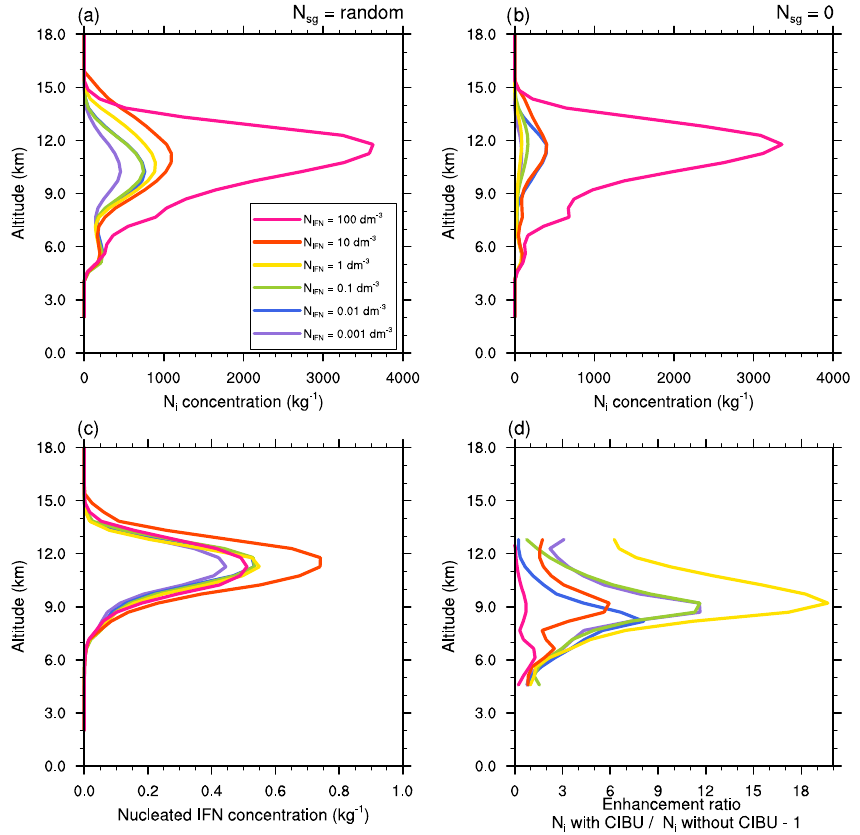
Figure 14. Mean profiles of cloud ice crystal concentration for initial IFN concentrations from 100 to 0.001daym − 3 of the STERAO simulations corresponding to (a) the CIBU simulation and “RANDOM” case and (b) the non-CIBU simulation. The mean profiles of the nucleated IFN concentrations are plotted in panel (c) after rescaling to fit the [0.0, 1.0] range. The rough estimate of CIBU enhancement factor of N i is plotted in panel (d) as a function of the initial IFN